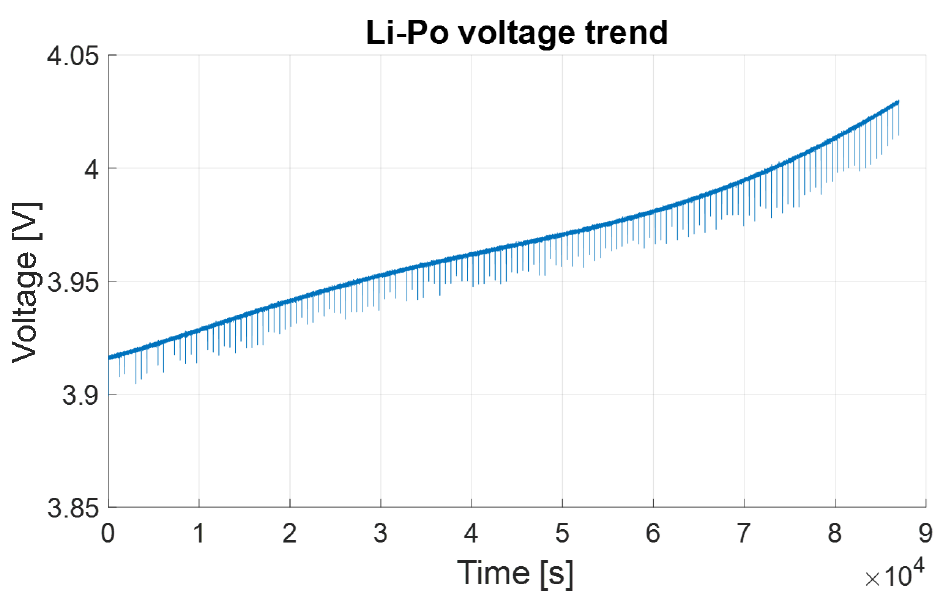
Figure 7. Li-Po voltage trend with radio transmissions every 10 min and ∆ T = 30 °C.